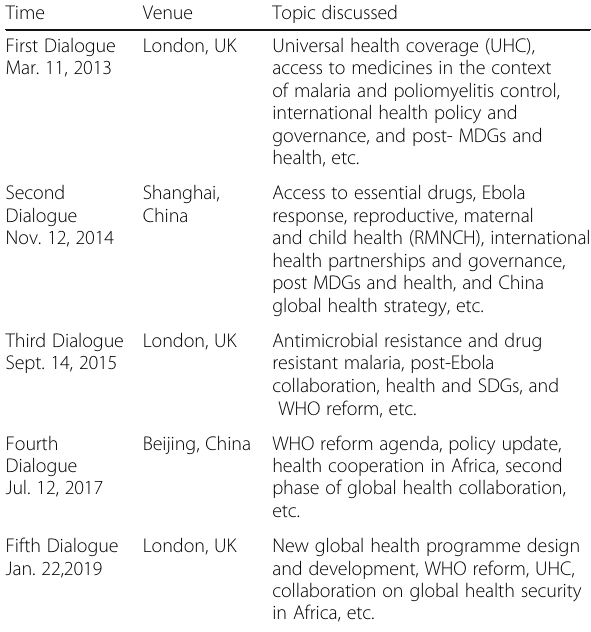
Table 3 Topics discussed in China-UK Global Health